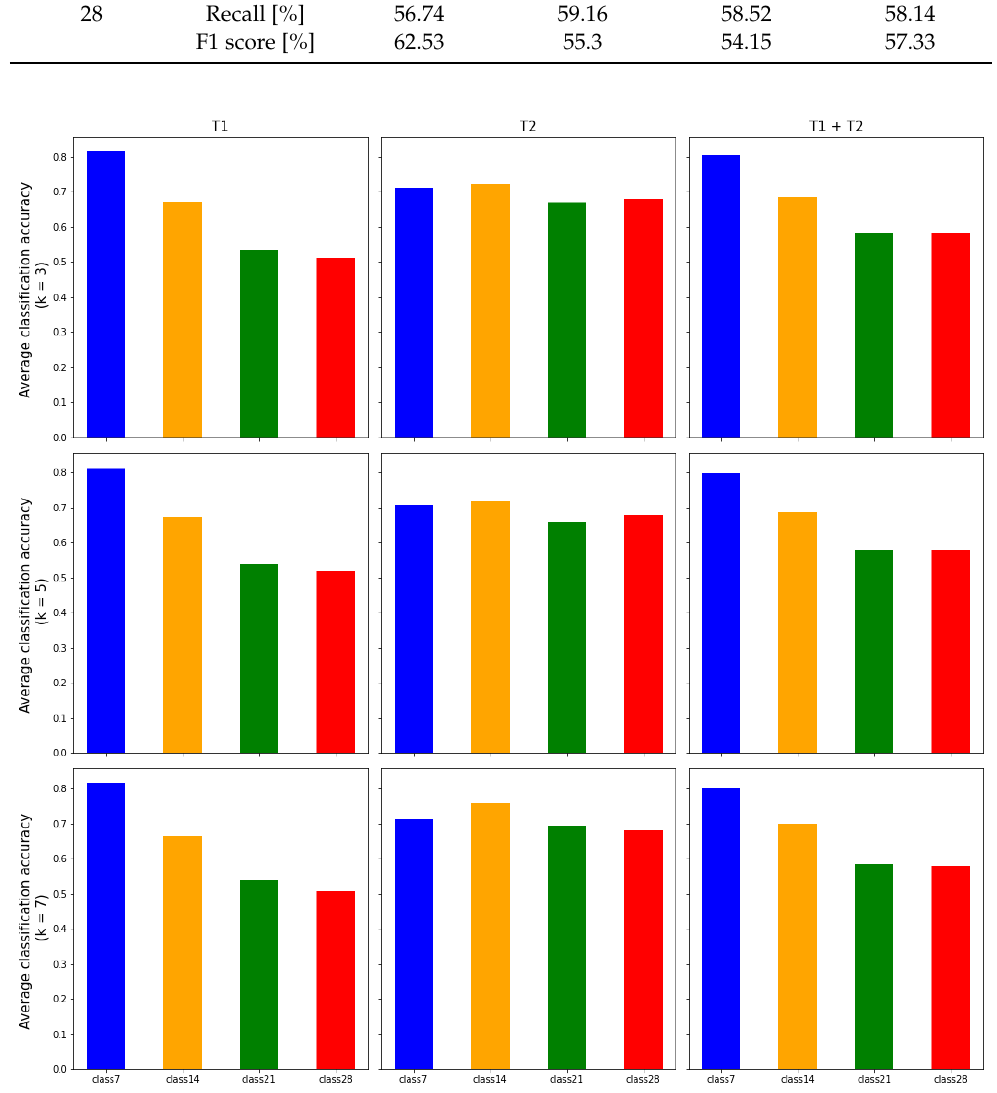
Figure 5. Average classification